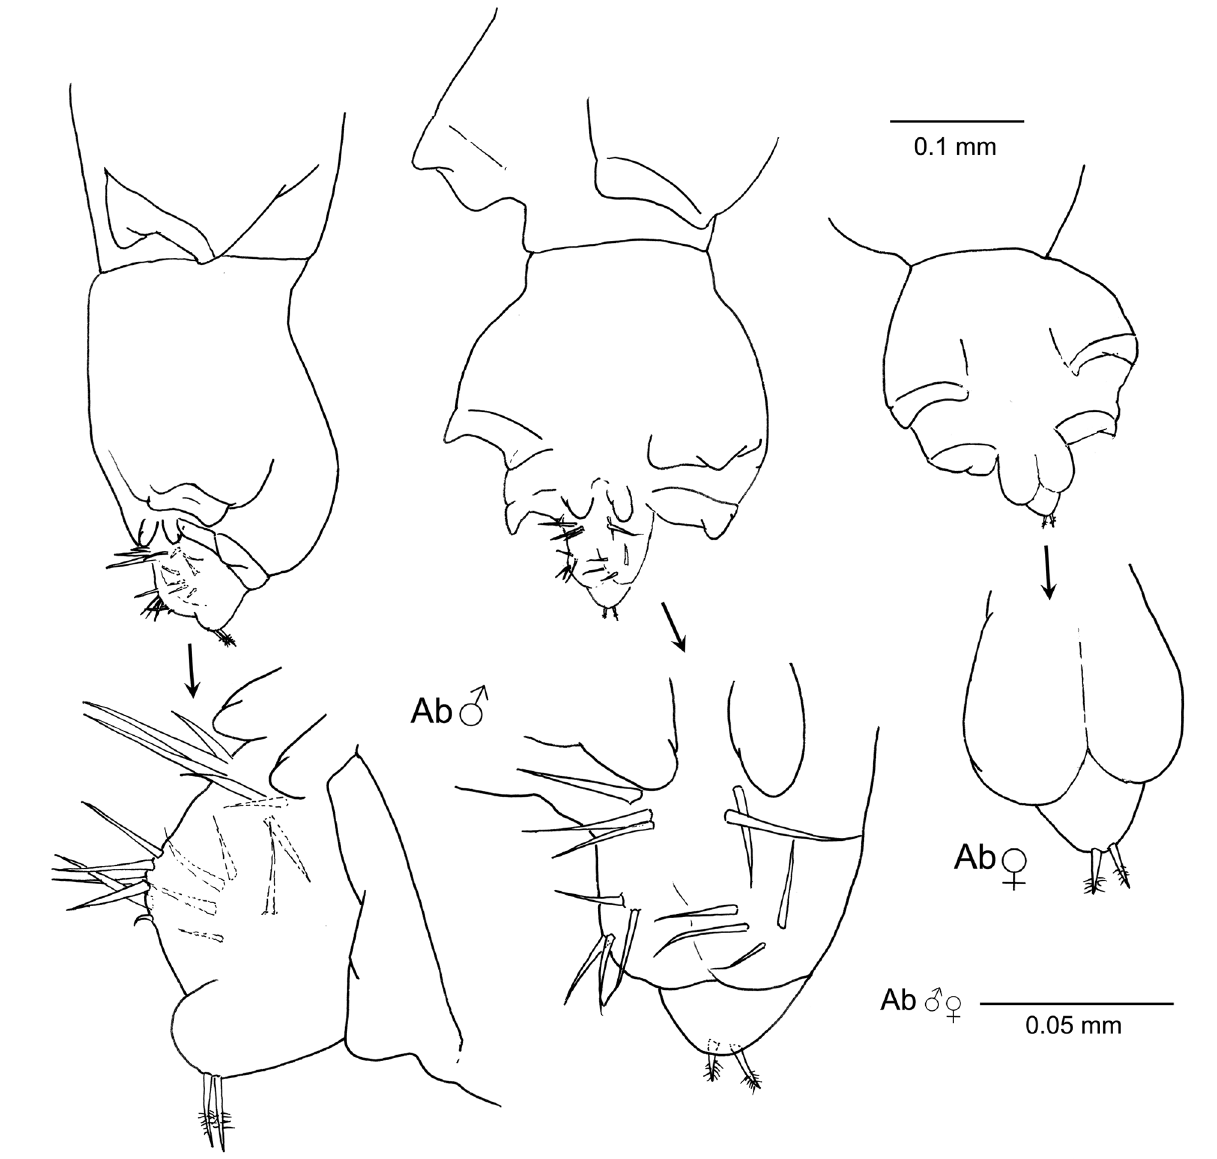
Figure 6. Parapseudaeginella australiensis n. sp. Pereonites 6 and 7 showing the total fusion and details of male and female abdomen [lateral and ventral view of holotype male (WAM C76110), and ventral view of paratype female (AM P.101303)]. Abbreviation: Ab =